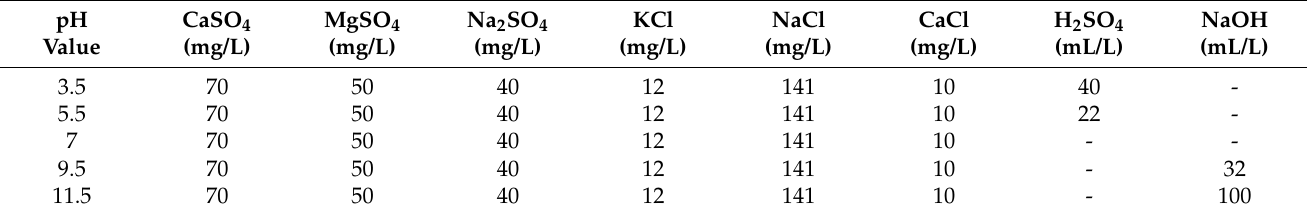
Table 2. Concentration of substances in the simulated mine water.